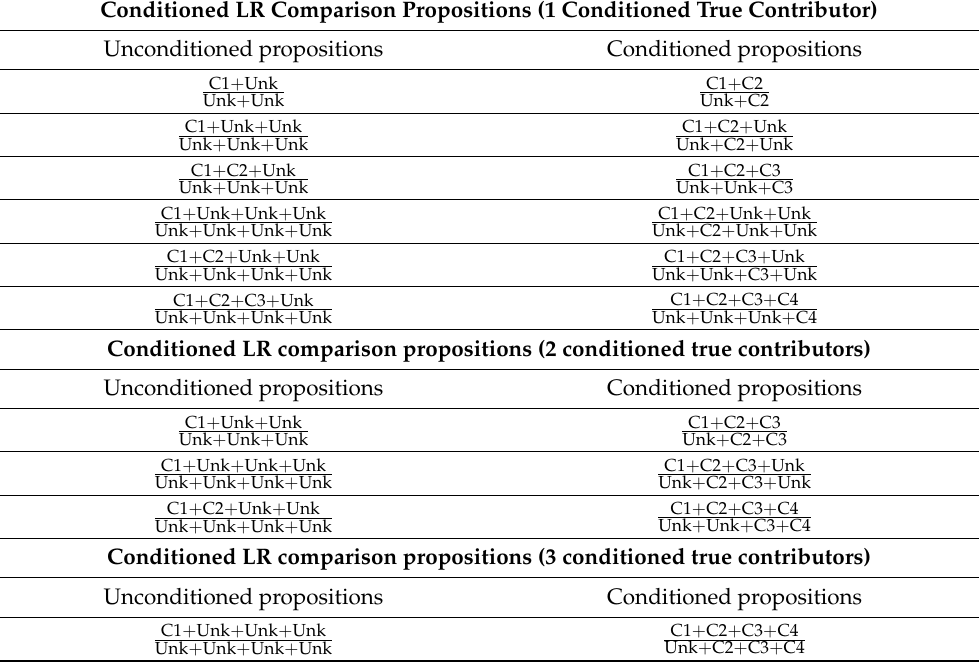
Table 4. Propositions for unconditioned v. conditioned LR comparison. Note that this comparison applies to compound LRs as well as simple LRs; for instance, for the three-person mixtures, both the simple and 2-person compound LRs were compared to their conditioned